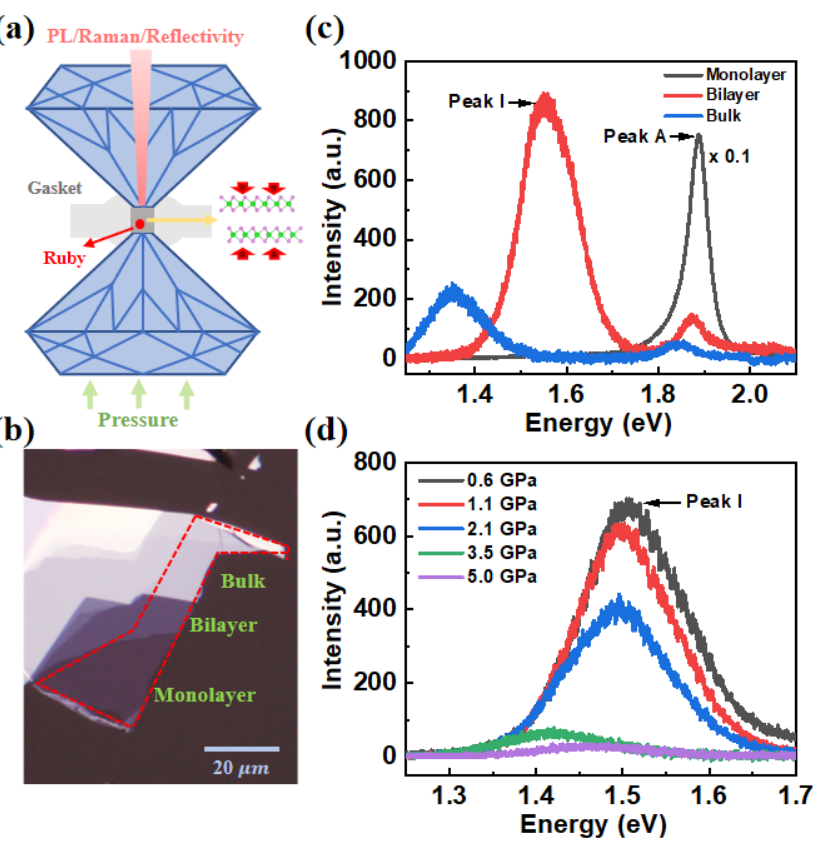
Figure 1. ( a ) Schematic diagram of DAC, which is mainly composed of atop anvil, bottom anvil and gasket. ( b ) Optical microscope images of monolayer, bilayer and bulk MoS 2 on top of PDMS. ( c ) PL spectra of monolayer, bilayer, and bulk MoS 2 without the top anvil. ( d ) PL spectra of bilayer MoS 2 at different pressures.